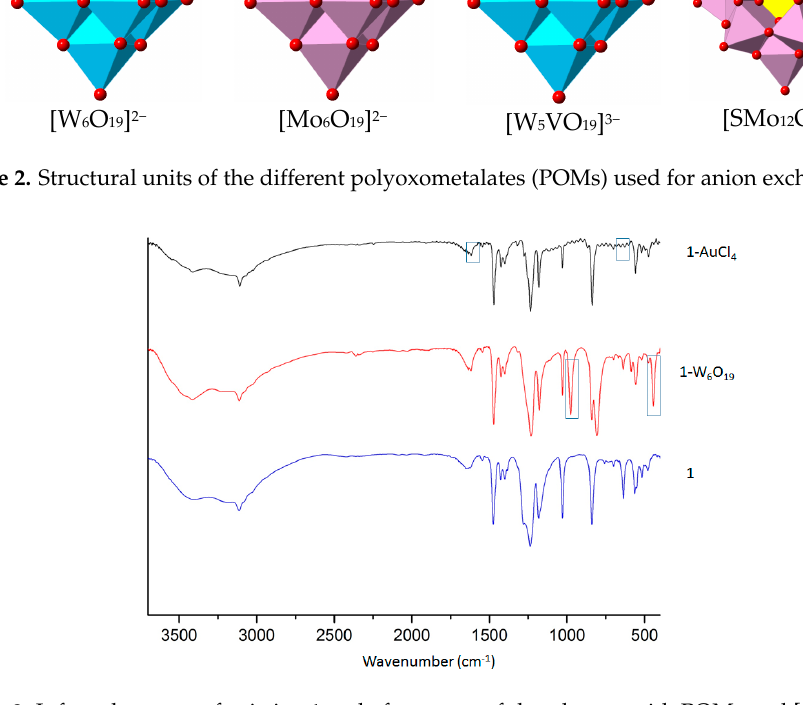
Figure 3. Infrared spectra of pristine 1 and after successful exchange with POMs and [AuCl 4 ] − . The different boxes highlight the main changes due to the incorporation of the new species.